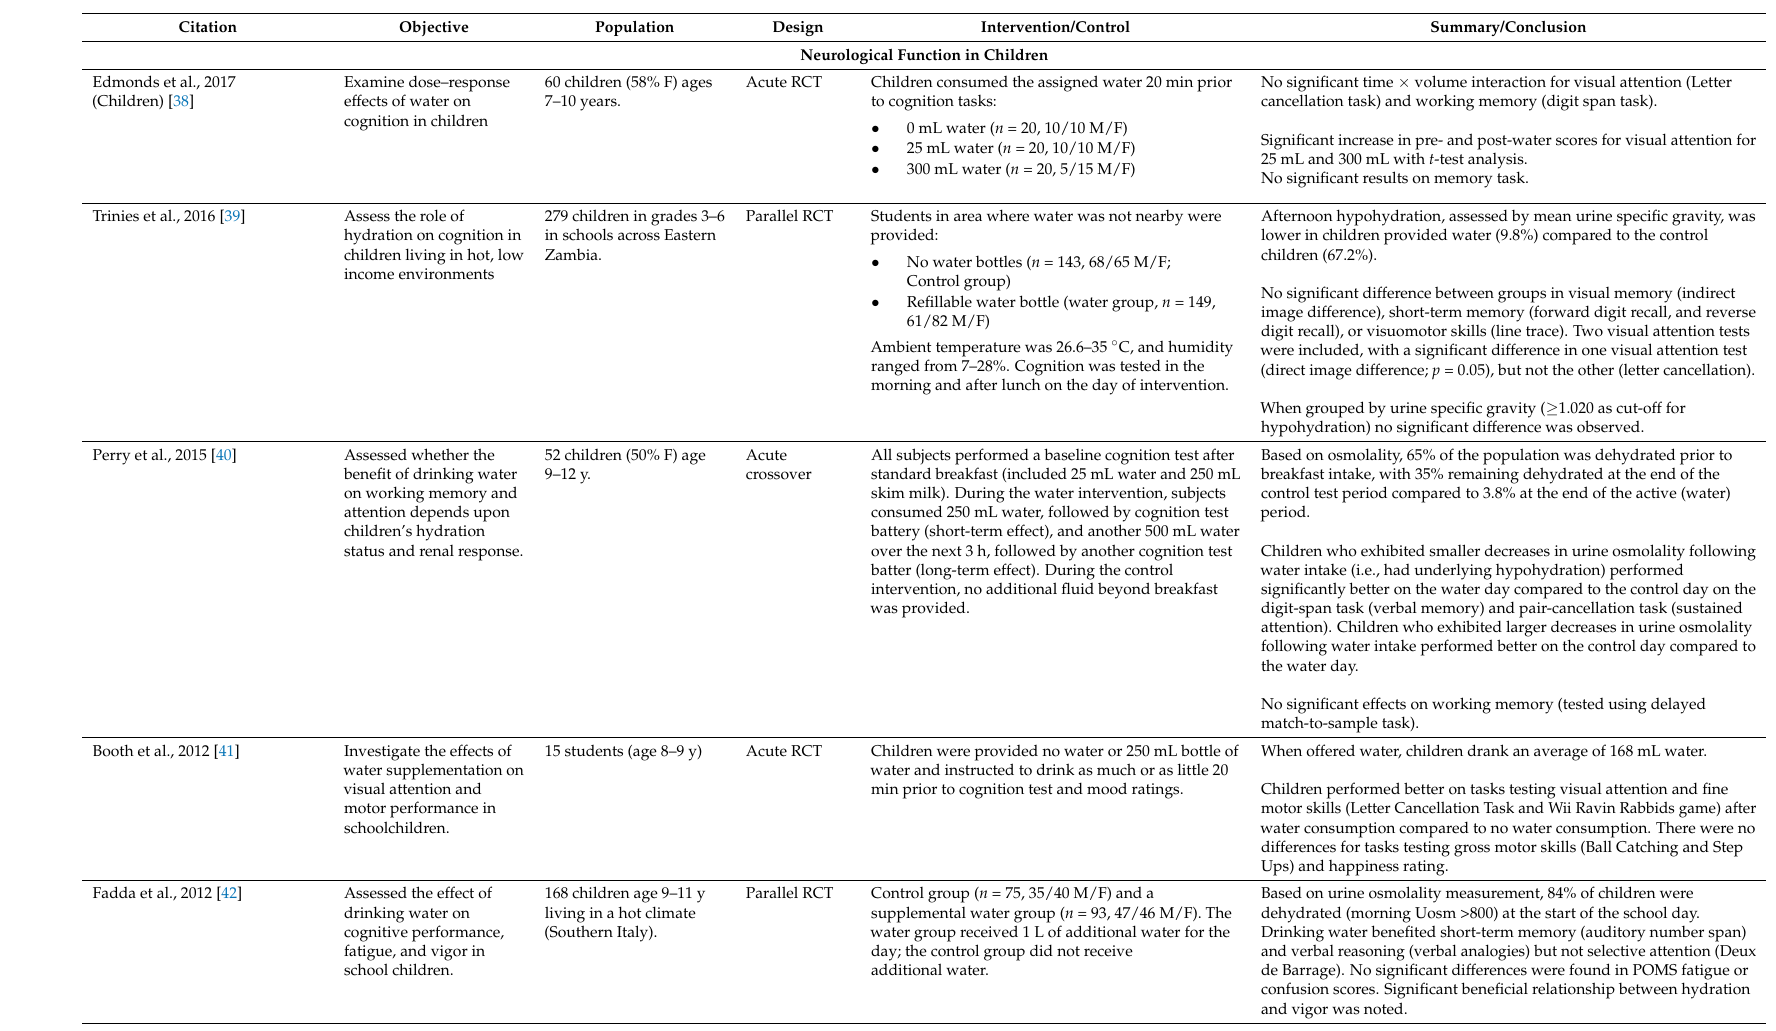
Table 2. Intervention Studies on Hydration and Neurological Function 1